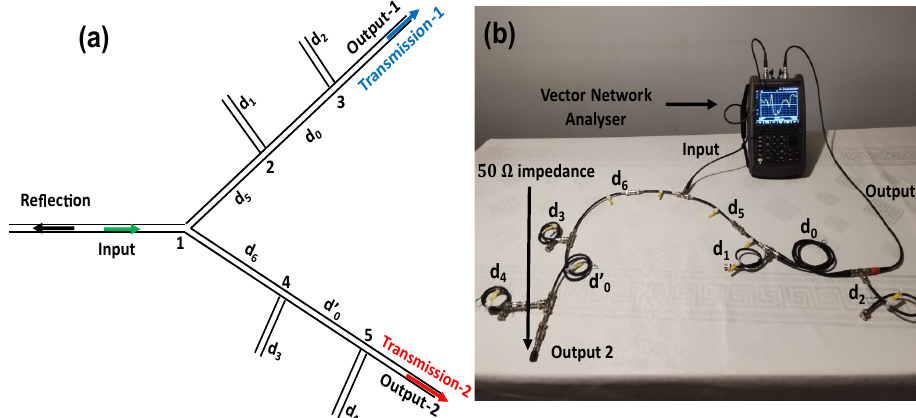
Figure 1. ( a ) Schematic representation of the Y-shaped demultiplexer with one input line and two output lines. Each output consists of U-shape resonators where two stubs are placed at different sites along the output line. See the text for the details of the geometrical parameters of the waveguides. ( b ) Experimental setup of the Y-shaped demultiplexer performed with standard coaxial cables connected to the vector network analyzer. The boundary conditions at the end of the stubs are H = 0. The different lengths of the cables are indicated in accordance with ( a ). When one output line is connected to the analyzer entrance, the second output is 50 Ohm impedance matching in order to avoid any reflection of the wave at the end of this